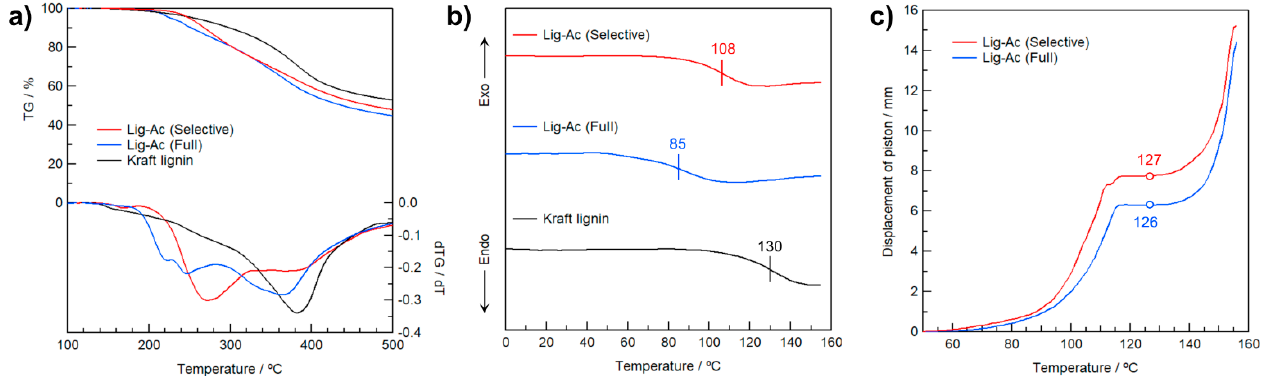
Figure 6. a ) TG-DTG and b ) DSC curves of Lig-Ac (Selective), Lig-Ac (Full), and Kraft lignin and c ) thermal flow curves of the acetyl Figure 6. ( a ) TG-DTG and ( b ) DSC curves of Lig-Ac (Selective), Lig-Ac (Full), and Kraft lignin and ( c ) thermal flow curves derivatives expressed as displacement of a piston in a capillary rheometer. of the acetyl derivatives expressed as displacement of a piston in a capillary